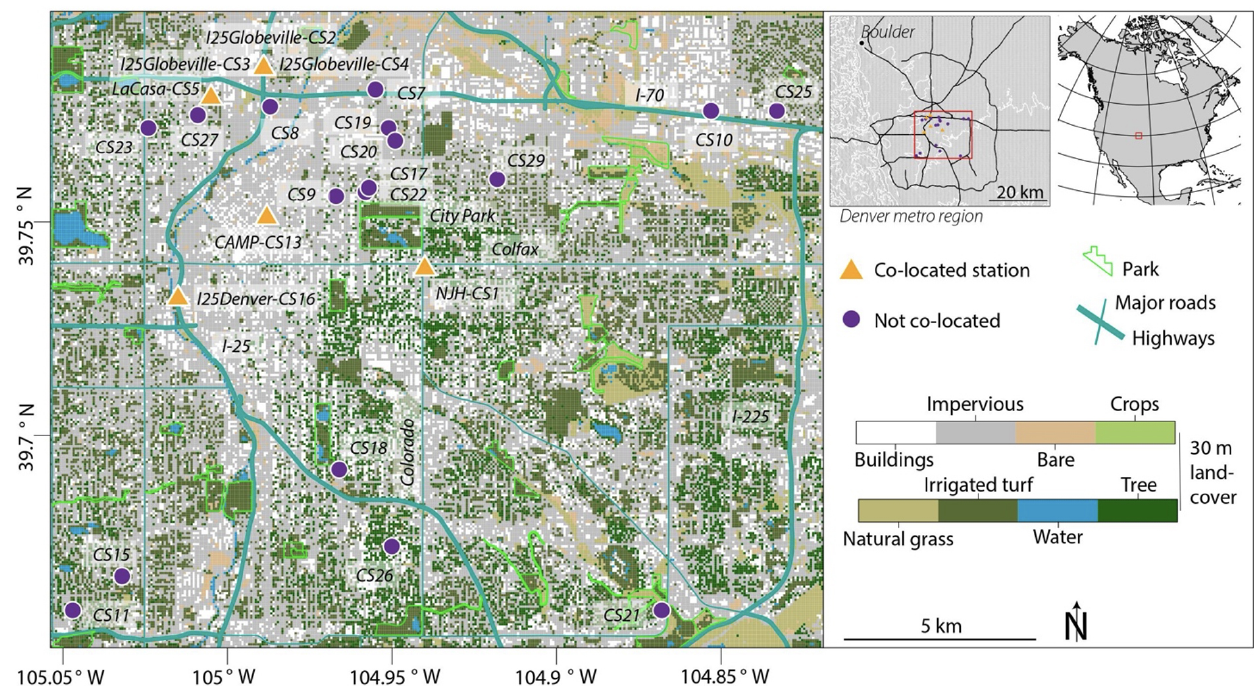
Figure 1. Locations of all 24 Love My Air sensors. Sensors displayed with an orange triangle indicate that they were co-located with a reference monitor. The labels of the co-located sensors include the name of the reference monitor with which they were co-located after a